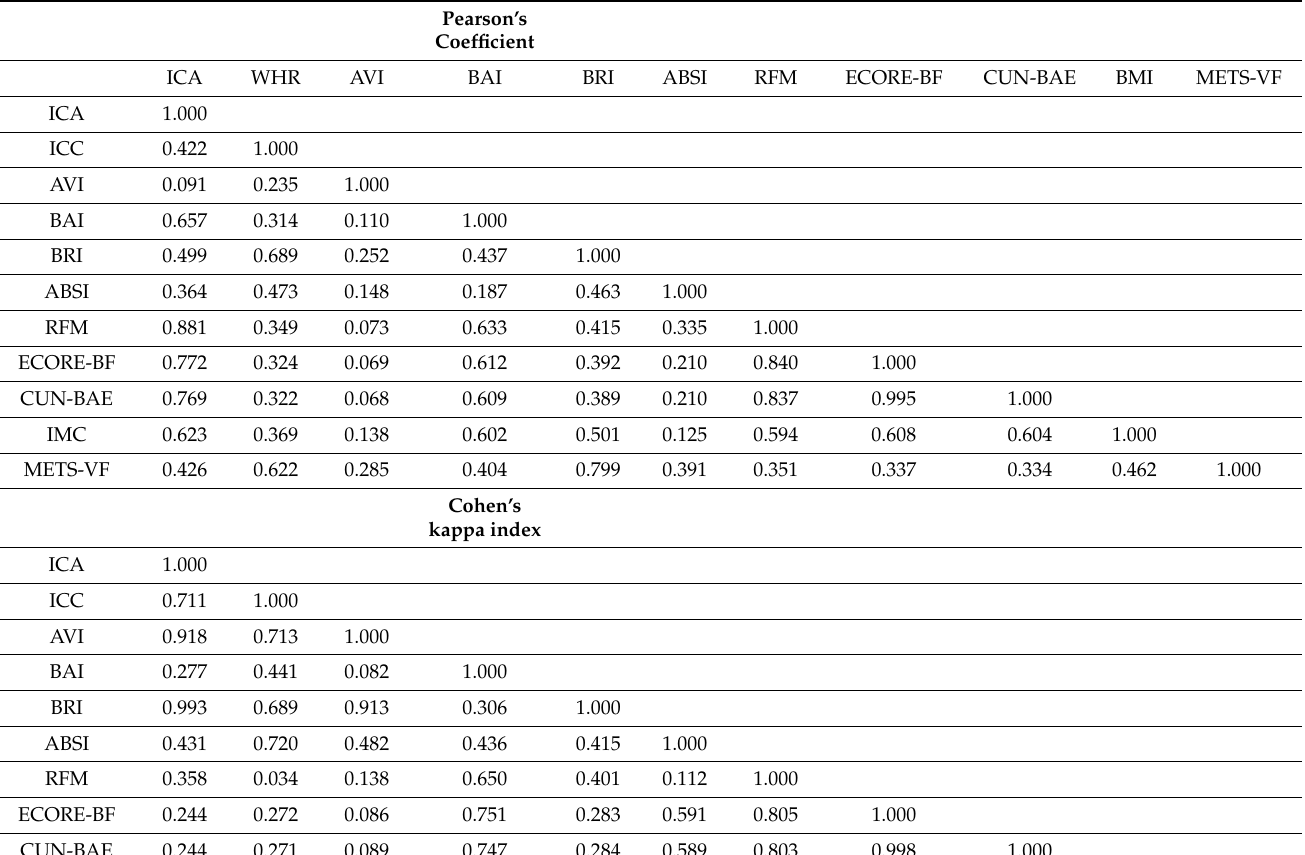
Table 5. Correlation and consistency between the formulas used in the